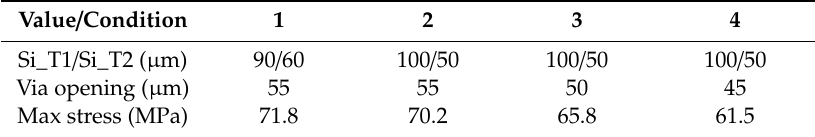
Figure 6. Stress distribution of pad in one TC cycle. Table 2. The max S33 stress in the pad center for di ff erent structure design. Table 2. The max S33 stress in the pad center for different structure design.